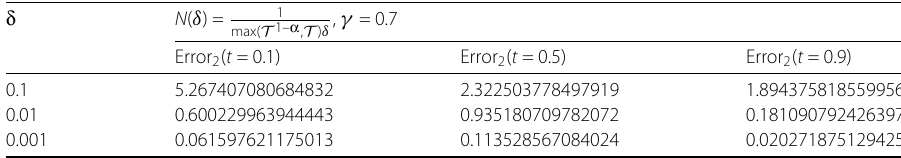
Table 8 The output errors for t ∈ { 0.1;0.5;0.9 } , δ ∈ { 0.1;0.01;0.001 } , and α = 0.8 in case 2